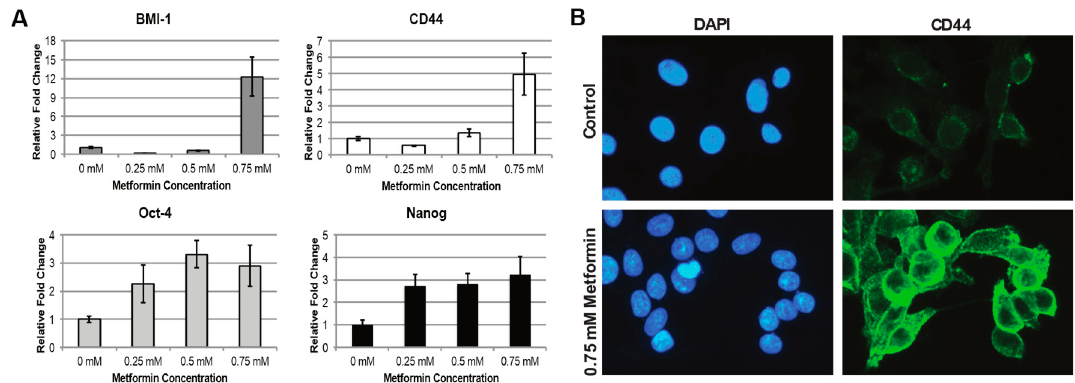
Figure 2. Metformin increases stem cell marker levels. ( A ). Plots of qPCR-measured gene expression level fold changes for stem cell markers after treatment of JLO-1 cells to different concentrations of metformin. ( B ). Immunofluorescence visualization of CD44 distribution on the cell surface before and after treatment with 0.75 mM metformin. The cell nuclei were stained with DAPI. All images were taken at 40× magnification.